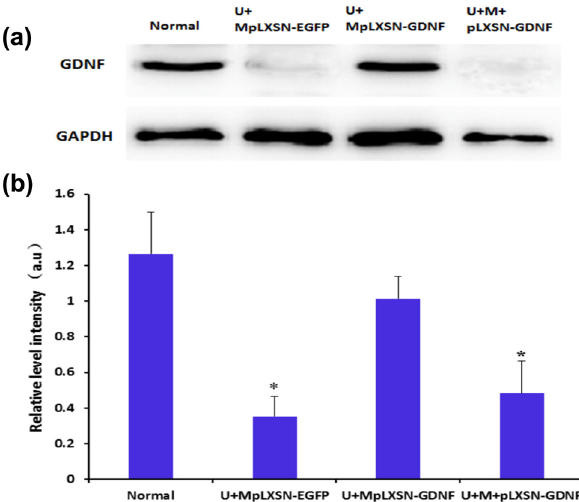
Figure 3: Rotation test after 8 weeks of treatment; the rats were subjected to an apomorphine - induced rotation test to the left by intraperitoneal injection of 0.5 mg/kg apomorphine. The U + M + pLXSN - GDNF group showed a signi fi cant di ff erence between before and after treatment, * P <